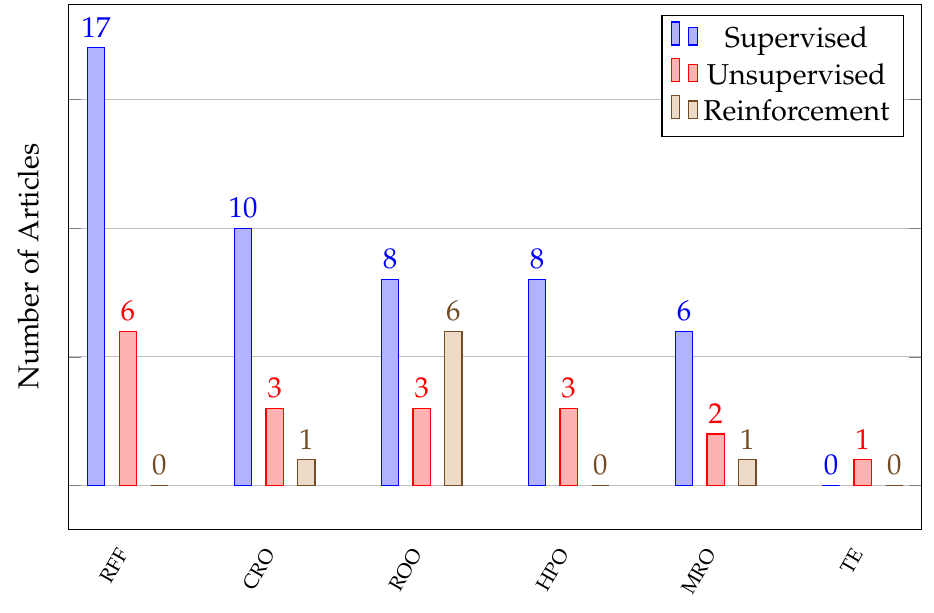
Figure 7. Machine learning vs main